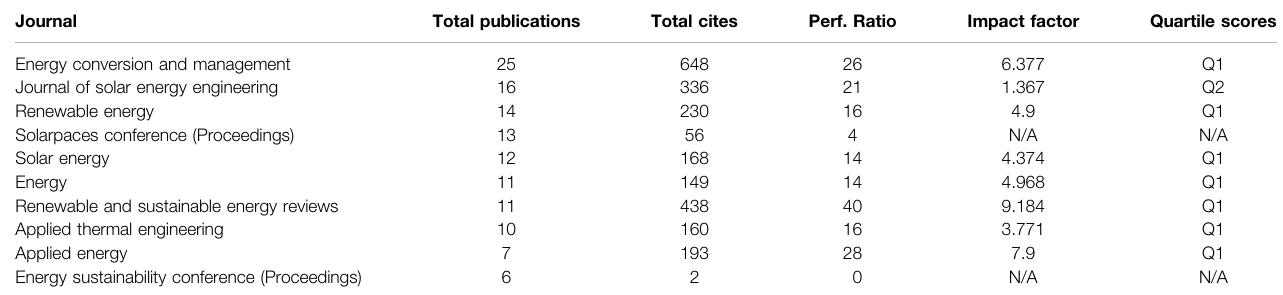
TABLE 15 | Top 10 journals in the Stirling Dish fi eld.